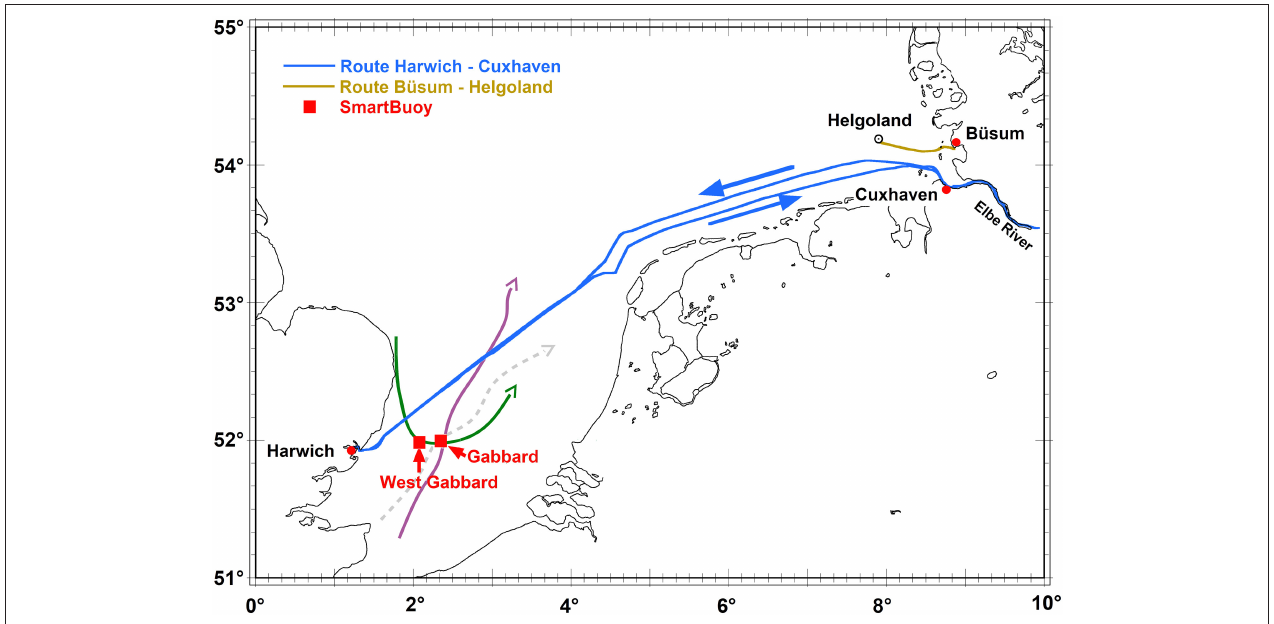
FIGURE 1 | Ferry routes between Helgoland and Büsum, between Cuxhaven and Harwich and locations of the SmartBoy stations Gabbard and West Gabbard. Example trajectories are drawn that illustrate different pathways of water parcels either from Gabbard to the ferry transect (purple) or from the ferry transect to Gabbard (green). The colors agree with the color map used in Figure 7 . Finally, the dashed gray line provides the example of a water parcel being probed at Gabbard but never seen by the FerryBox